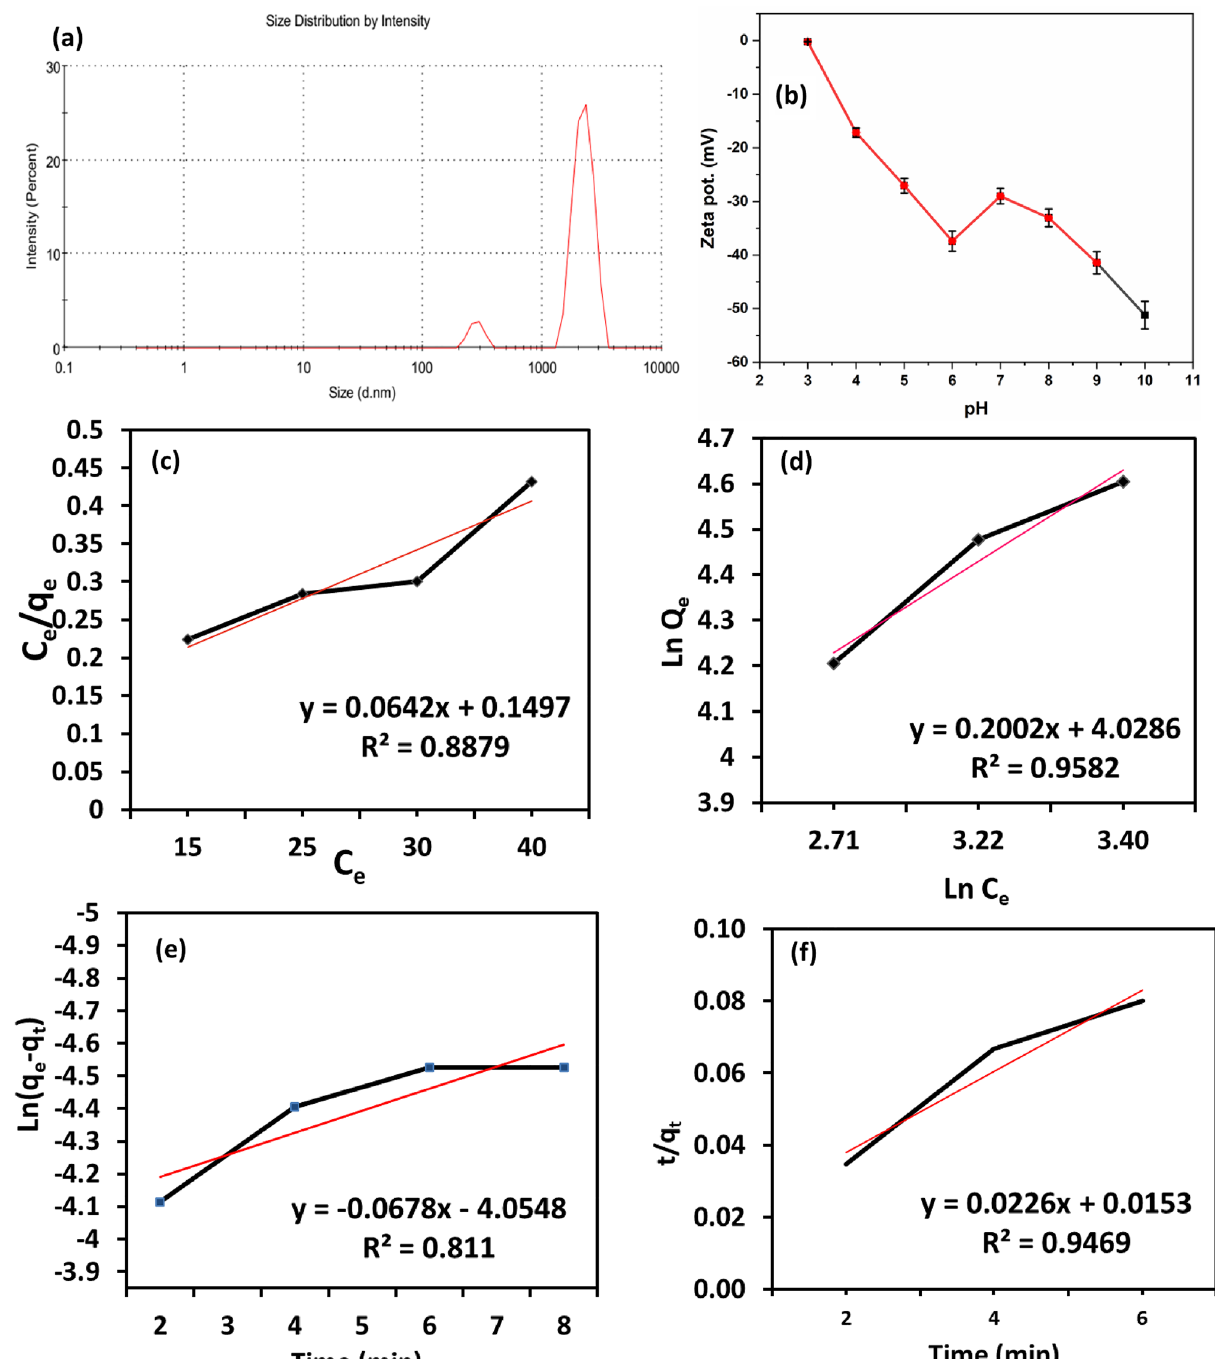
Figure 8. ( a ) Particle size analysis of PAK, ( b ) Zeta potentials of PAK, ( c ) Langmuir, ( d ) Freundlich, ( e ) Pseudo First Order (PPO), and ( f ) Pseudo-second Order (PSO) isotherm models for MB adsorption onto